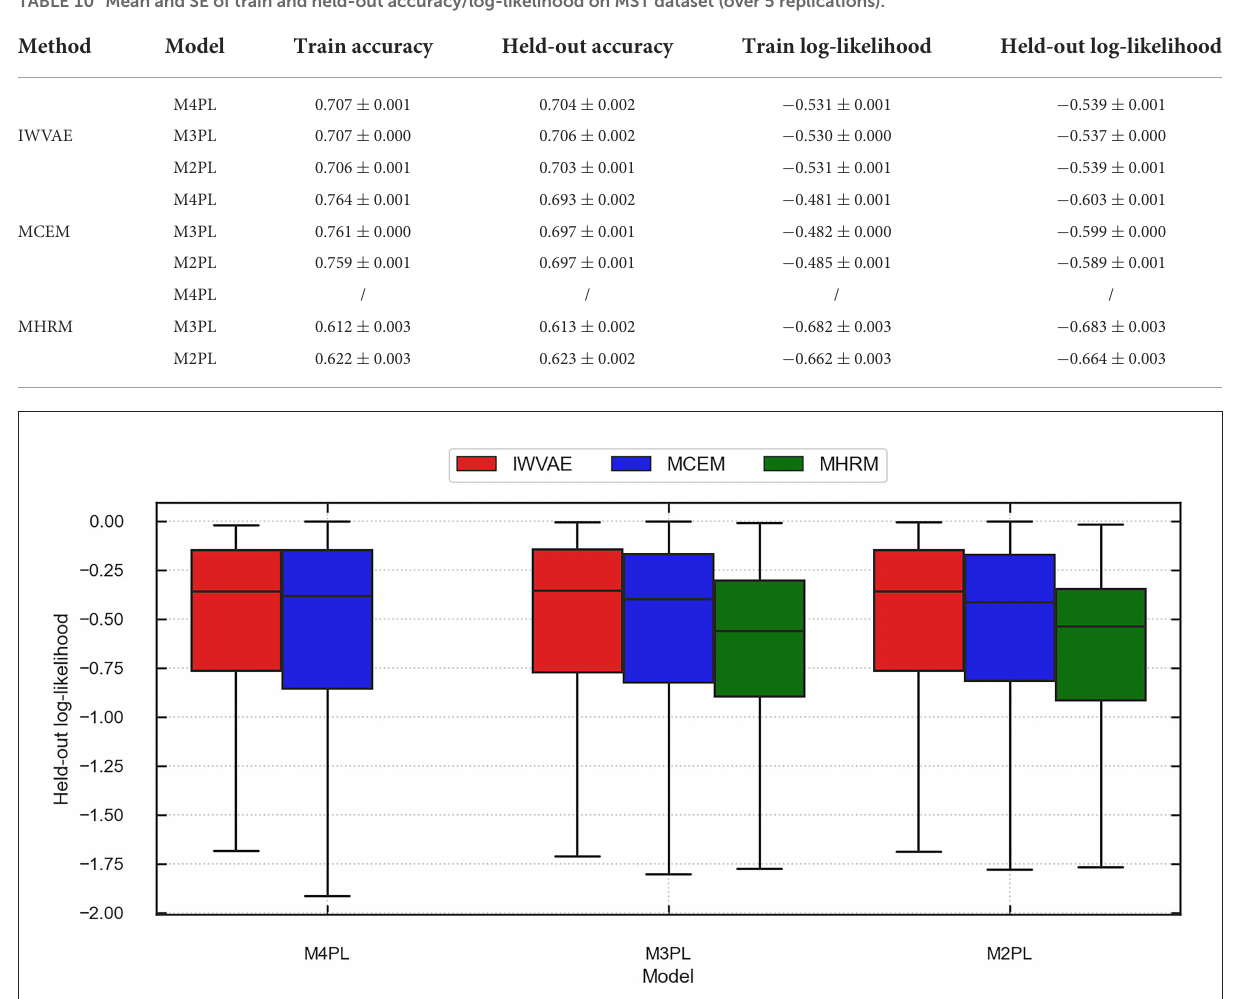
FIGURE3 Predicted log-likelihood on held-out items using different methods (IWVAE, MHRM, MCEM) to fit different MIRT models on MST data from a randomly selected trial. Outlier predictions are removed.